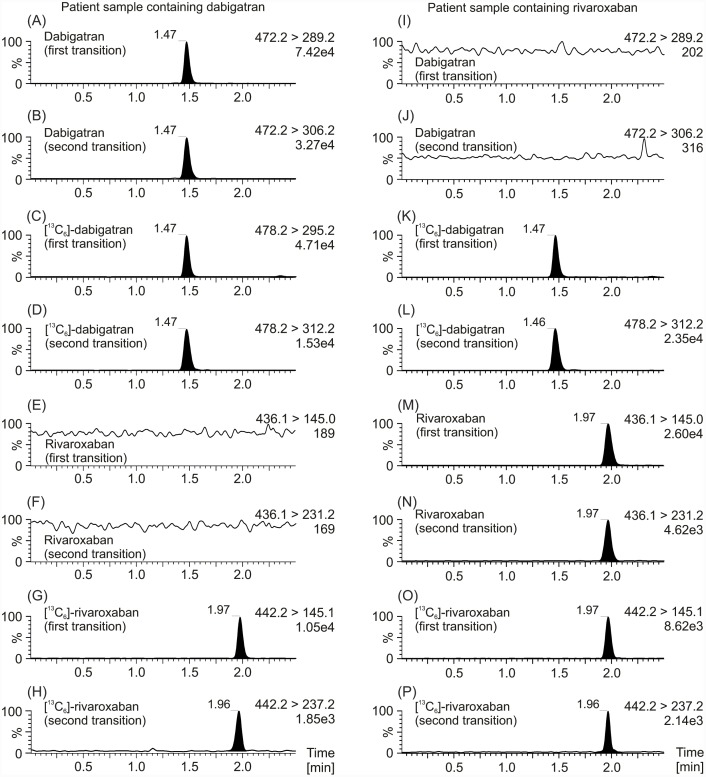
MRM chromatograms of patients’ plasma samples.MRM chromatograms of a plasma sample from a patient which have been treated with dabigatran are depicted on the left (A, B, E, F), as well as MRM chromatograms a plasma sample from a patient which have been treated with rivaroxaban are depicted on the right (I, J, M, N). MRM chromatograms of the internal standard [13C6]-dabigatran (C, D, K, L) concerning dabigatran, as well as the internal standard [13C6]-rivaroxaban (G, H, O, P) concerning rivaroxaban are also shown. The first mass transition which was used for quantification of the drug, as well as the second mass transition which was used for verification is plotted. Data were normalized to largest peak in the plots. An estimated peak height is shown in the plots below the transition remark.